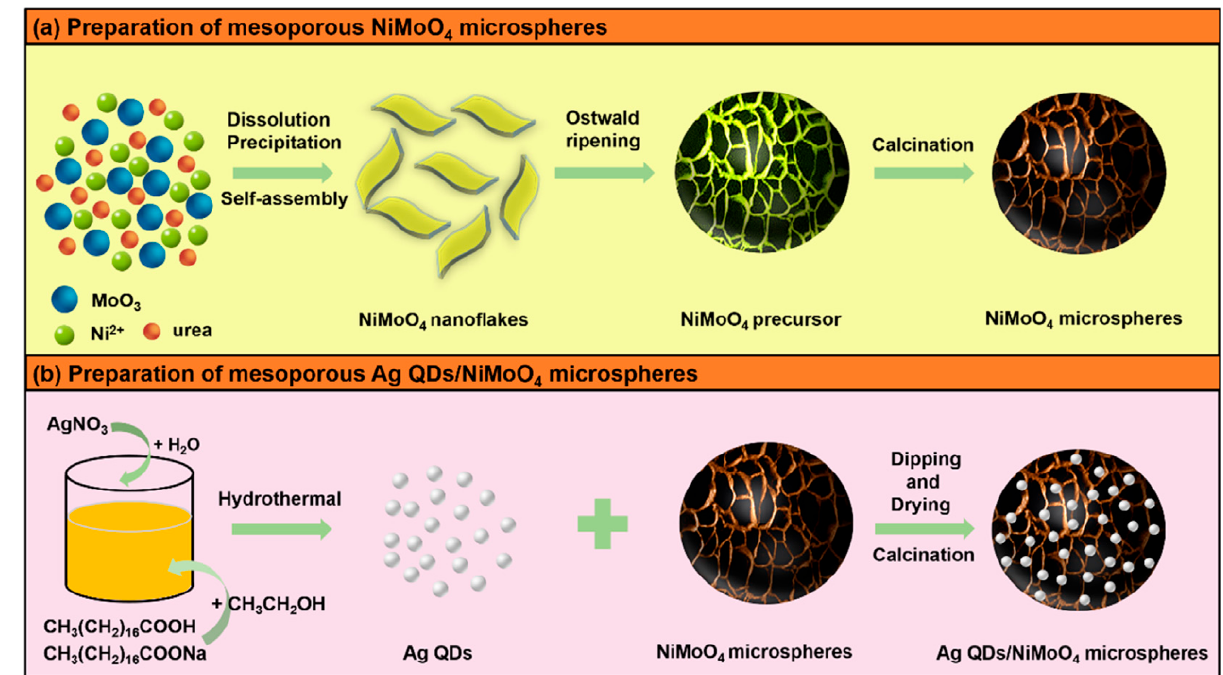
Figure 10. ( a ) Schematic illustration of the synthesis processes for mesoporous NiMoO 4 microspheres; ( b ) schematic illustration of the synthesis processes for Ag quantum dots (QDs)/NiMoO 4 microspheres. Reproduced with permission from [192]. Copyright 2020